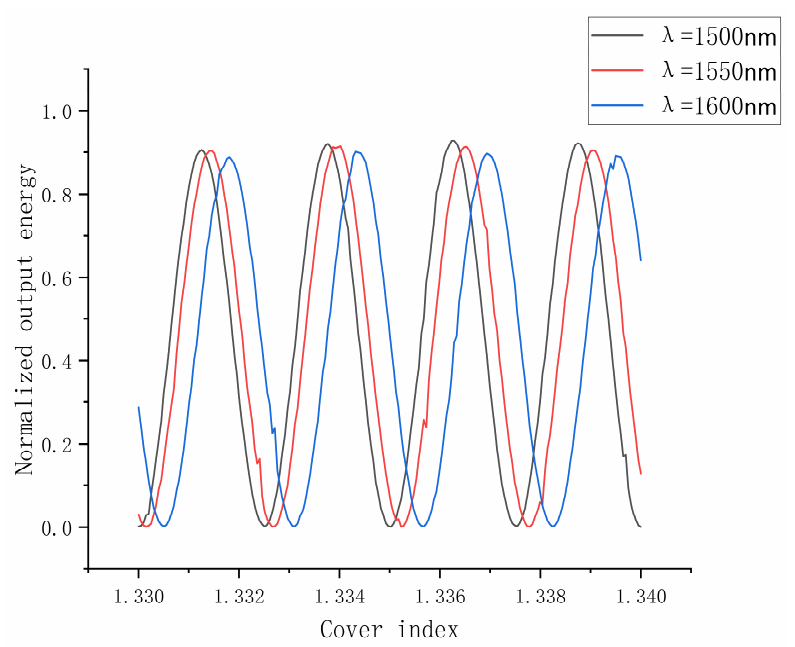
Figure 9. The relationship between the normalized output energy with the refractive index for the structure at wavelengths of 1500, 1550, and 1600